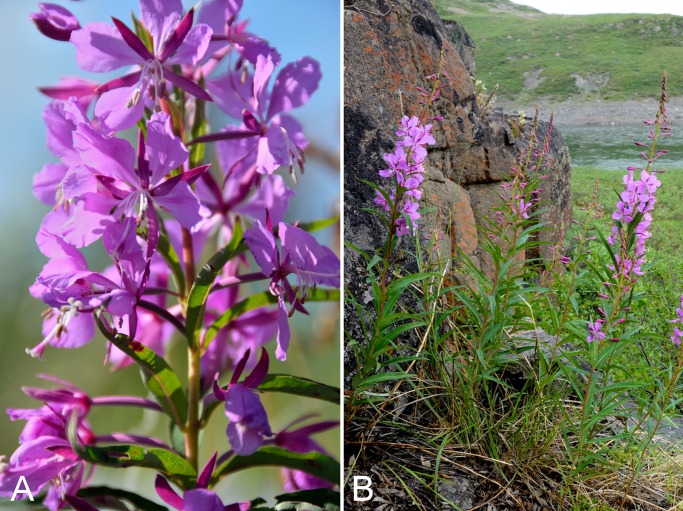
Chamerion angustifolium subsp. angustifolium.(A) Inflorescence, vicinity of lower Coppermine River, Nunavut, 7 July 2014. (B) Habit, Saarela et al. 4081. Photographs by R. D. Bull.